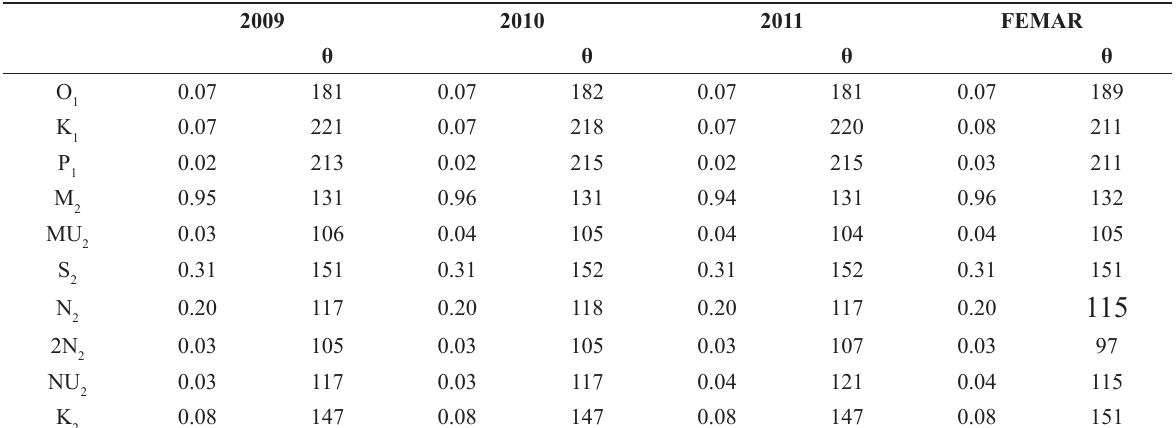
Main diurnal and semi-diurnal harmonic constituents for 2009, 2010, and 2011, and the same ones published by FeMaR (1999).